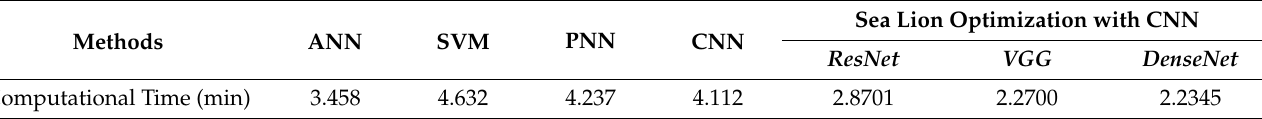
Table 10. Analysis on computational time for different